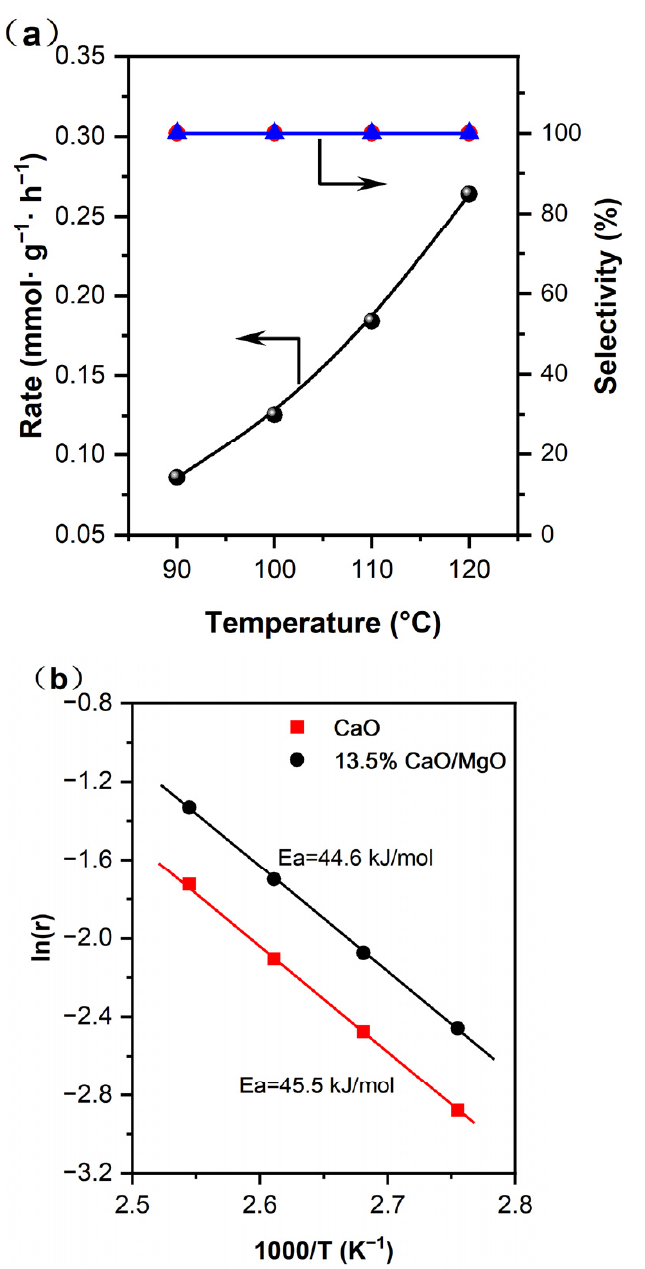
Figure 4. ( a ) The effect of temperature on the alcoholysis rate of NFM and product selectivities, ( b ) the relationship between ln ( r ) and 1/ T in the NFM alcoholysis reaction on 13.5% CaO/MgO. Reaction conditions: 0.3 g catalyst, 1.0 mmol NFM, 15 mL methanol, around 30% NFM conversion controlled by reaction time.